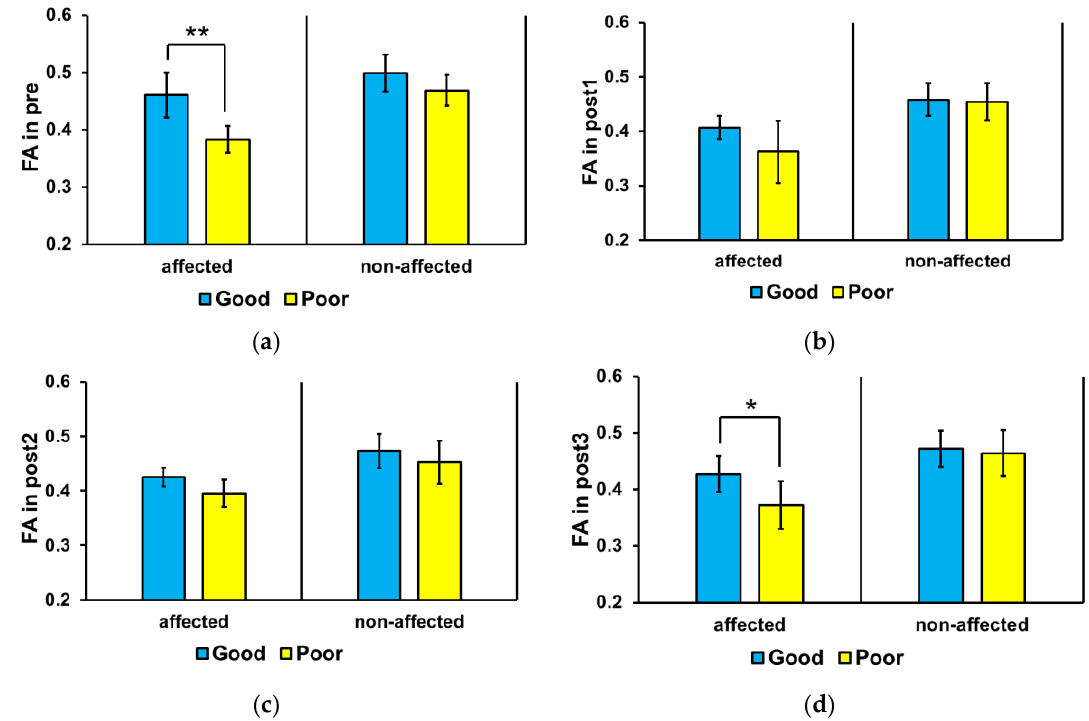
Figure 3. Mean corticospinal tract fractional anisotropy (FA) values in the affected and non-affected sides of the brain. In the affected side, the mean FA value was significantly higher in the good outcome group than that in the poor outcome group at pre (* p < 0.01) and post3 (* p < 0.05). Abbreviations: ( a ) baseline (pre), ( b ) 3 weeks after stroke onset (post1), ( c ) 3 months (post2), and ( d ) 6 months (post3).